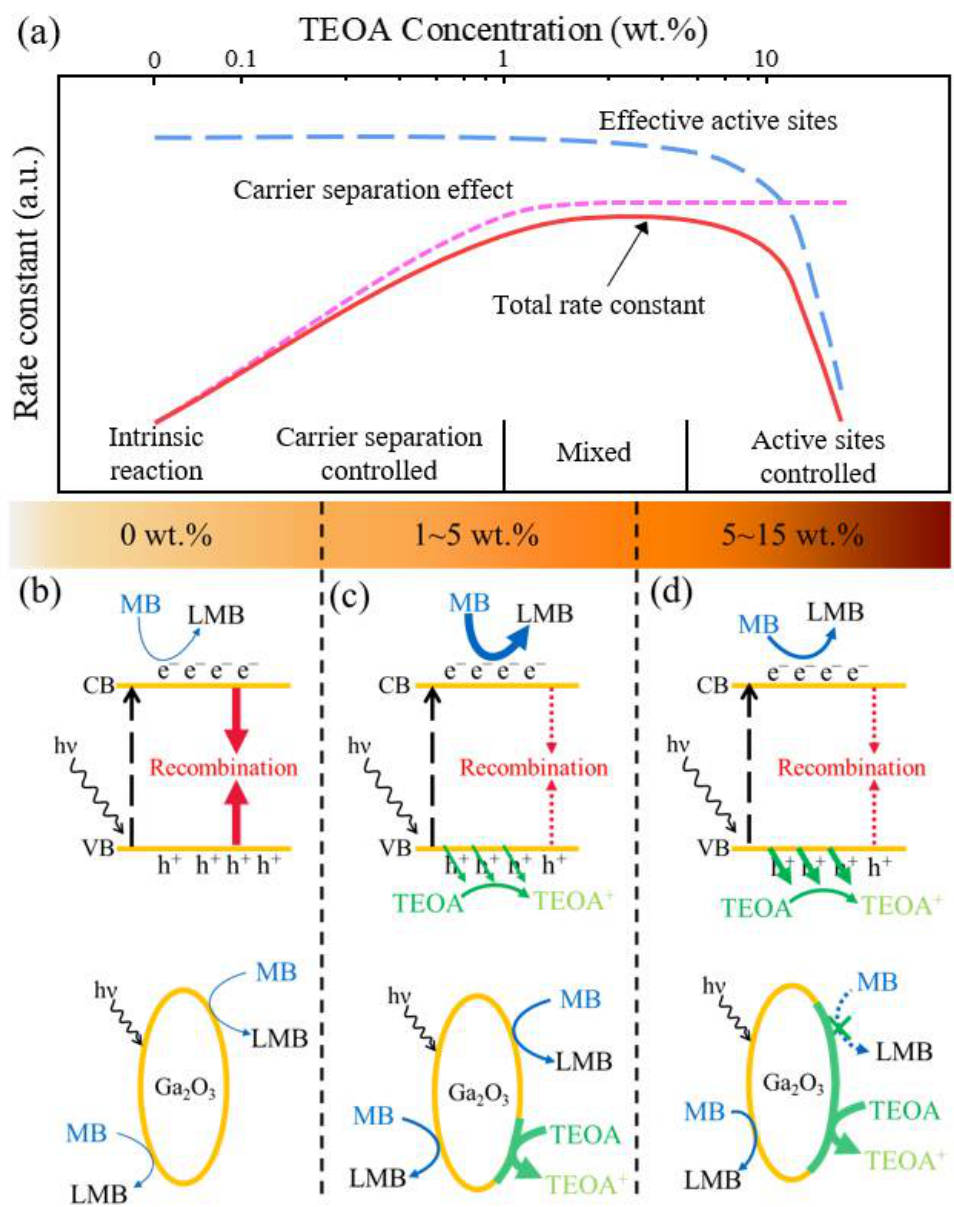
Figure 3. ( a ) Schematic drawing of the rate constants’ behavior, which considers two different effects: carrier separation and the number of effective active sites. The photocatalytic reduction mechanism of the MB solution with the Ga 2 O 3 photocatalyst ( b ) without TEOA, ( c ) with a low TEOA concentration (1–5 wt.%), and ( d ) with a high TEOA concentration (over 5 wt.%); TEOA + is an oxidized form of TEOA after scavenging a hole. CB: conduction band, VB: valence band, LMB: leuco-MB.